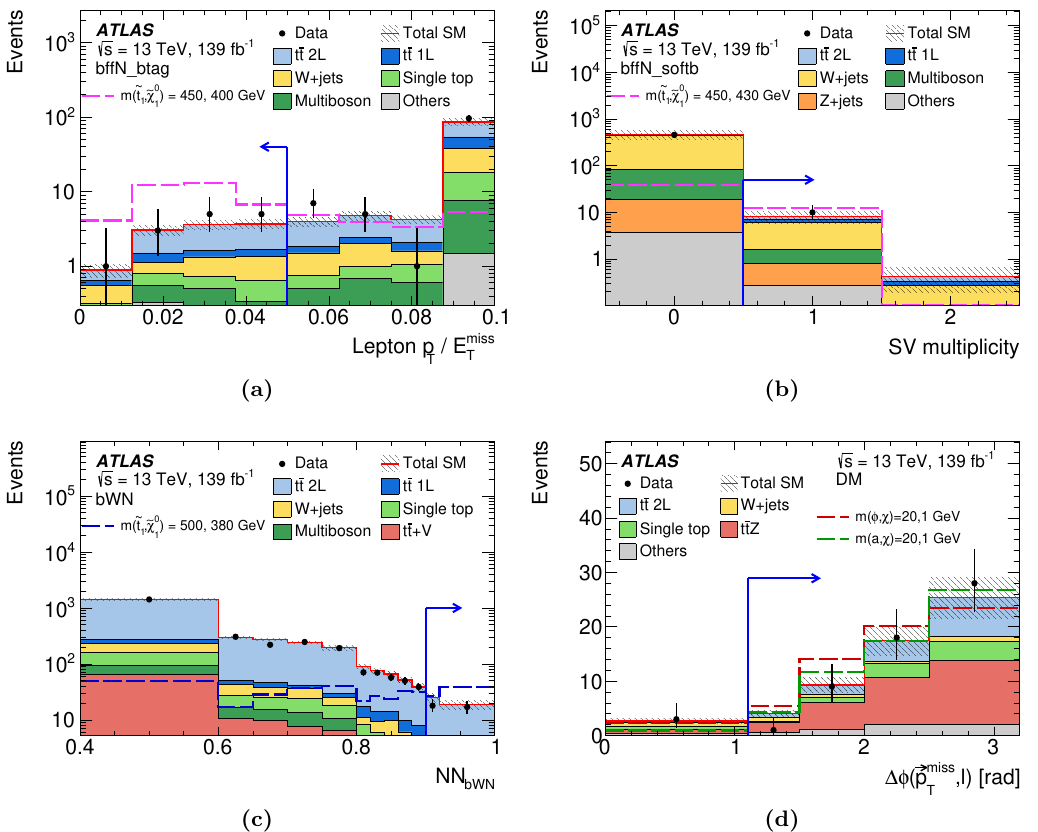
Figure 12. Kinematic distributions in the (a) bffN_btag , (b) bffN_softb , (c) bWN and (d) DM SRs. The full event selection in the corresponding signal region is applied, except for the requirement (indicated by an arrow) that is imposed on the variable being plotted. In the DM SR, the signal is normalised under the assumption of the coupling strength g =1.0. The distributions shown are post-fit, i.e. each background is scaled by a normalisation factor obtained from a background-only likelihood fit to the CRs (see table 14). In addition to the background prediction, a signal model is shown on each plot. The hatched area around the total SM prediction includes statistical and experimental uncertainties. The last (first) bin contains overflows